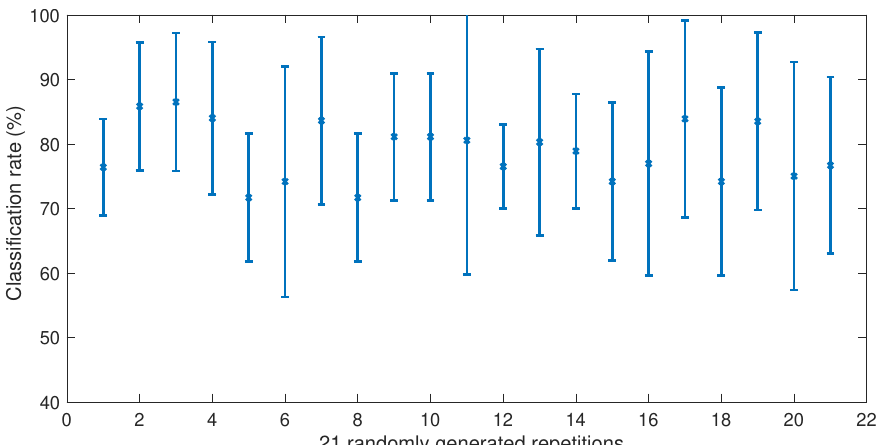
Figure 8. Five-fold cross validation experimentation. Horizontal axis: the experiments from 1 to 21. Vertical axis: the unit is percentage correct classification, the star indicating the average performance in that experiment. The width of the vertical interval about the mean is twice the standard deviation of the cross validation recognition rate in the experiment. The overall average rate, computed over all the experiments, is 79%, with a standard deviation of 4.6 units of correct classification. We also ran a PCA plot of the original data to gain some insight into the dataset layout (Matlab pca and scatter routines). The first five coefficients of PCA account for 92% of the variance. Figure 9 shows the scatter plot for PCA coefficient pairs (1,2), (1,3), (1,4), and (1,5). These plots are sufficient to indicate that the data of the two classes (FR and FT) are neither redundant nor do they cluster away from each other, i.e., the classification problem in this application is not trivial. In addition, the spread of the data of each class that the plots show is consistent with the variations in the classification results of the 21 5-fold cross validation experiments shown in Figure 8, confirming that, in general, the test data used in an experiment contains information not present in the training data.